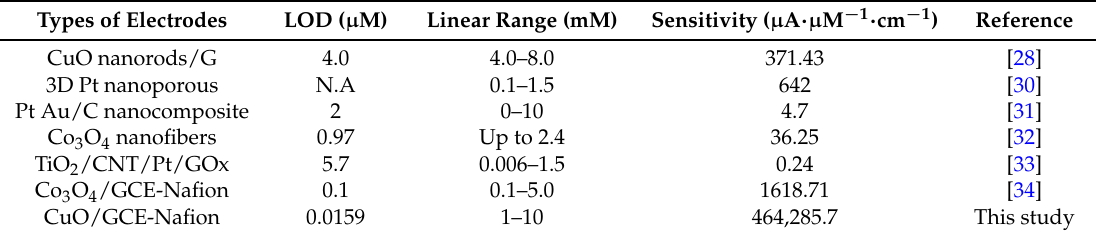
Table 1. The comparison of analytical parameters of various reported non-enzymatic glucose sensors with presented glucose sensor.